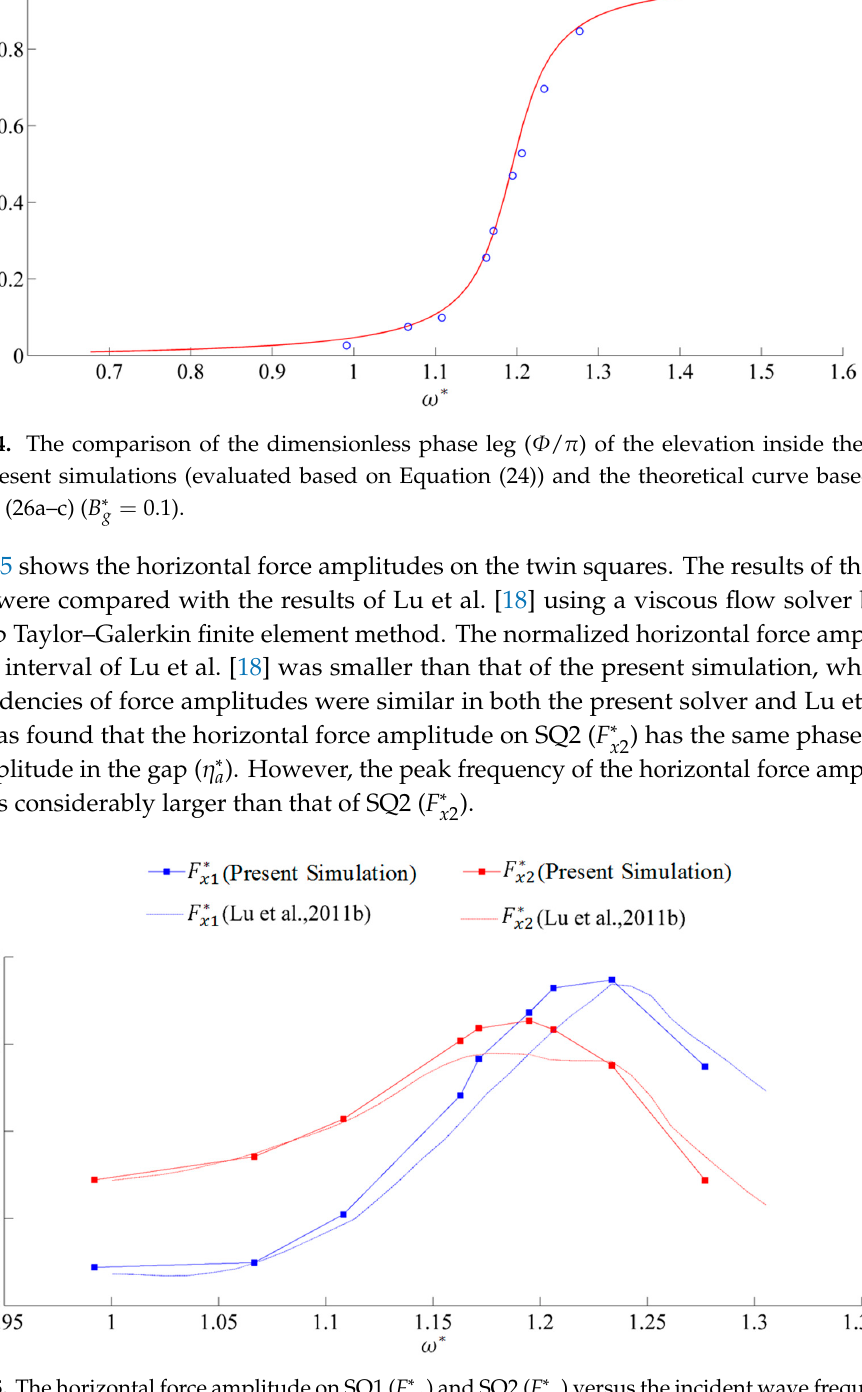
) and SQ2 ( F ∗ ) versus the incident wave frequency x 2 x 1